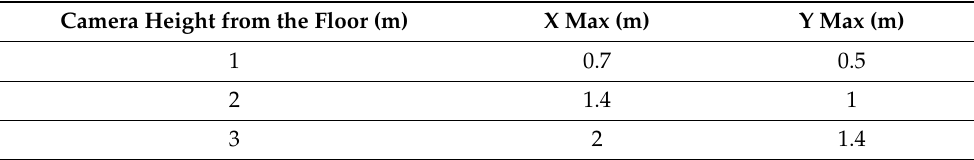
Table 1. The range of marker visibility on the measurement